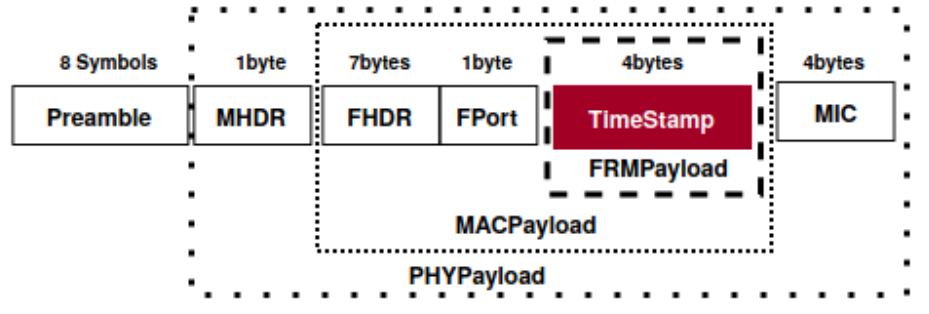
Figure 7. Format of a Synchronization message.